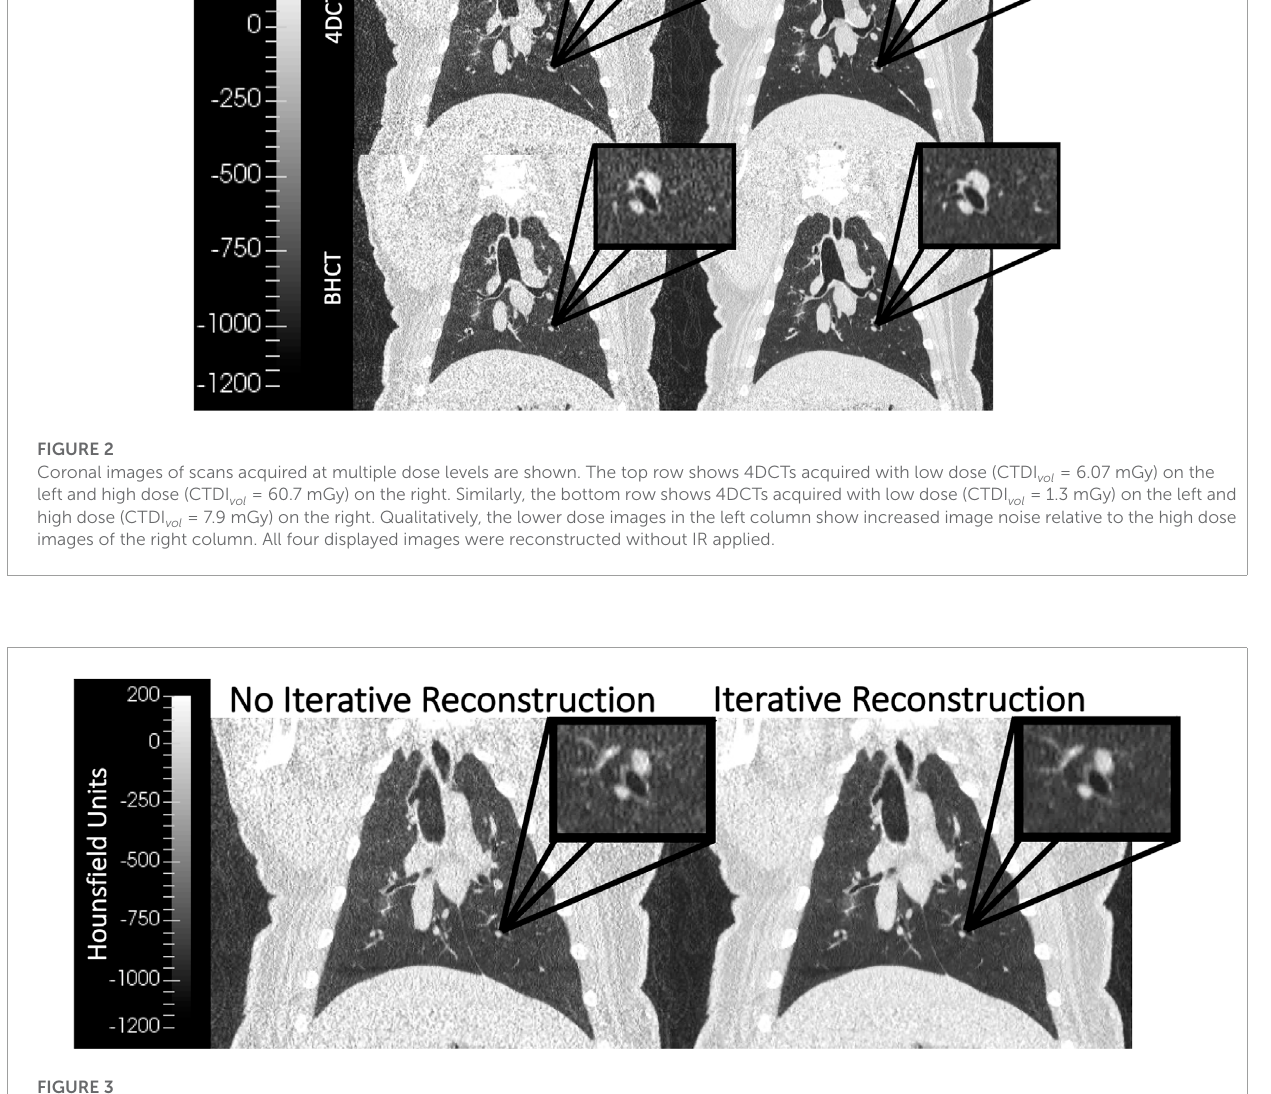
that do not expand and contract in conjunction with the global lung volume.Previousworkhasreportedthat7.6 %